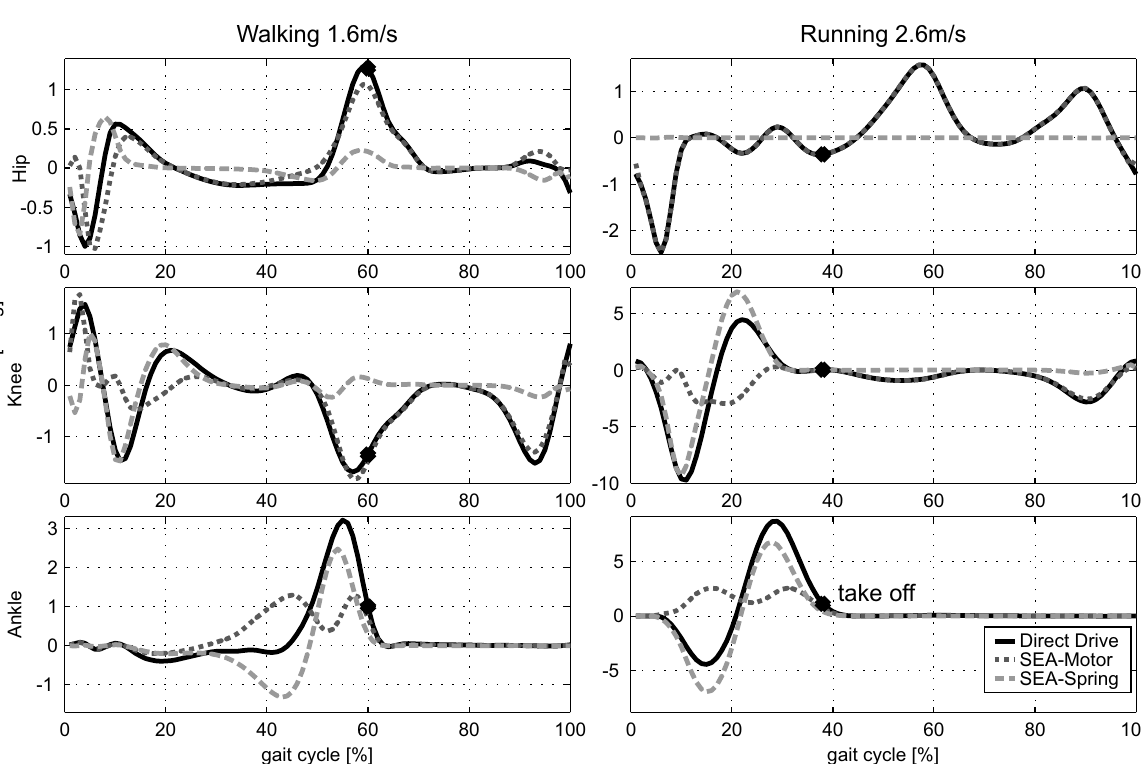
Figure 5. Hip, knee and ankle power for the gait cycle in human walking at 1.6 m/s and running at 2.6 m/s (mean of all subjects). The power is shown for the direct drive (black solid) and when an SEA drives the joint. For the latter, power is shared between the SEA motor (dark grey dotted) and the SEA spring (light grey dashed). The combination of the SEA motor and the SEA spring matches the direct drive situation. For the hip, for running, a rigid system without a spring requires the least energy. As a result, the SEA motor matches the direct drive